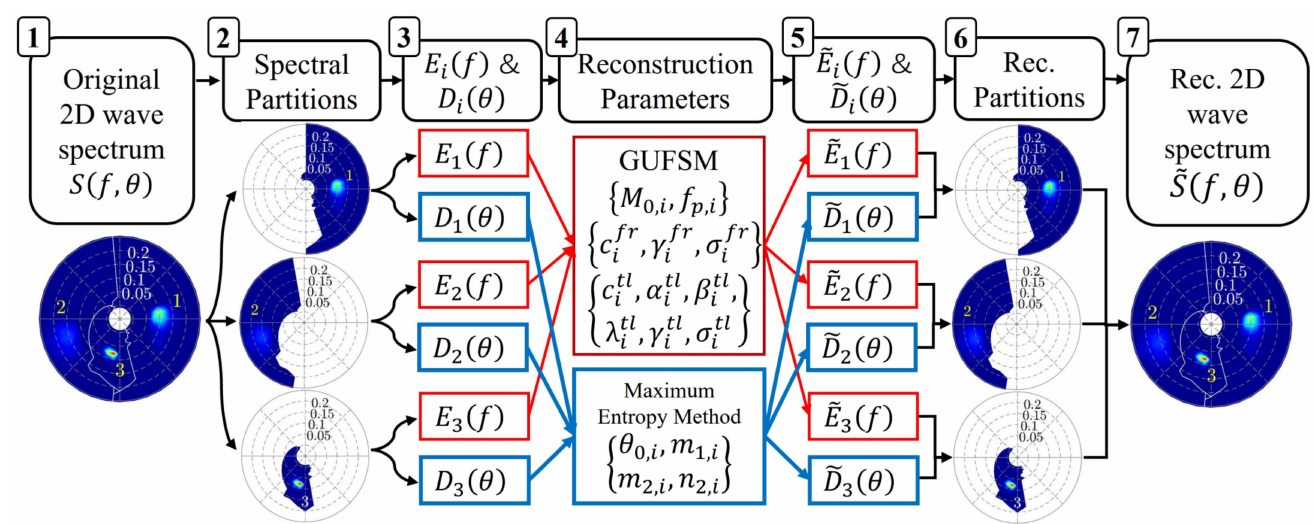
Figure 1. Steps (from 1 to 7) for preserving and reconstructing a 2D wave